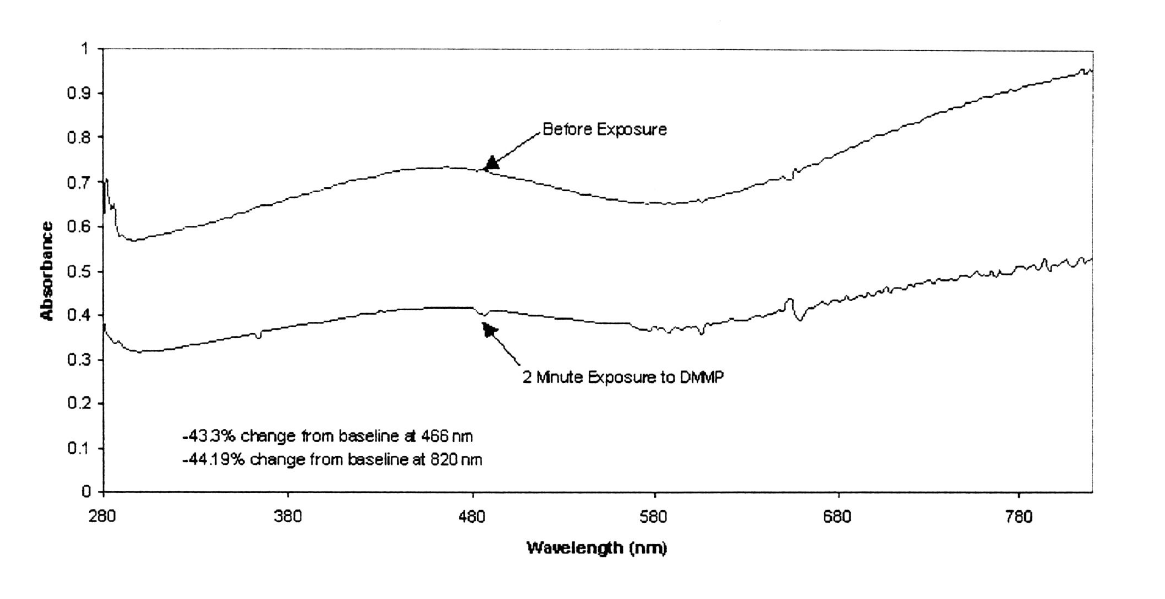
Figure 5. Polypyrrole film response to